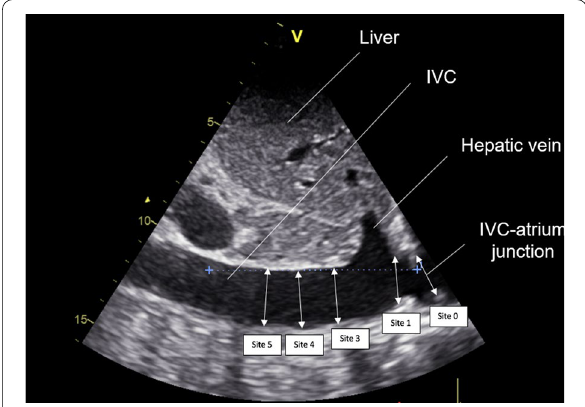
Fig. 1 Bi-dimensional ultrasound recording of the inferior vena cava (IVC) generated using the sub-costal, long-axis view. Measurement of IVC diameters were carried out at five sites: at the IVC–right atrium junction (site 0), then at 1 (site 1), 3 (site 3), 4 (site 4) and 5 cm (site